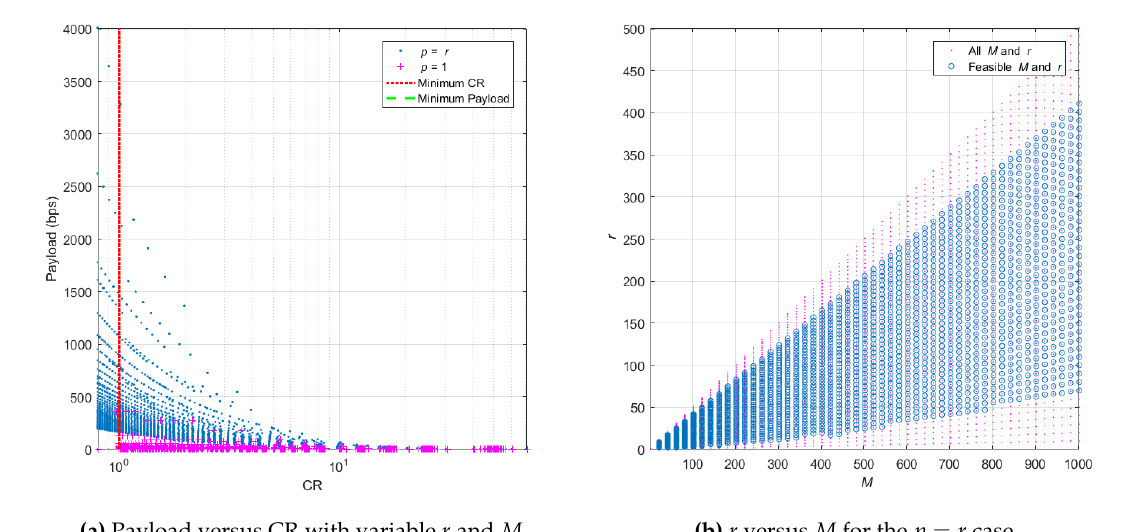
Figure 3. Finding feasible M and r to obtain payload >20 bps and CR >